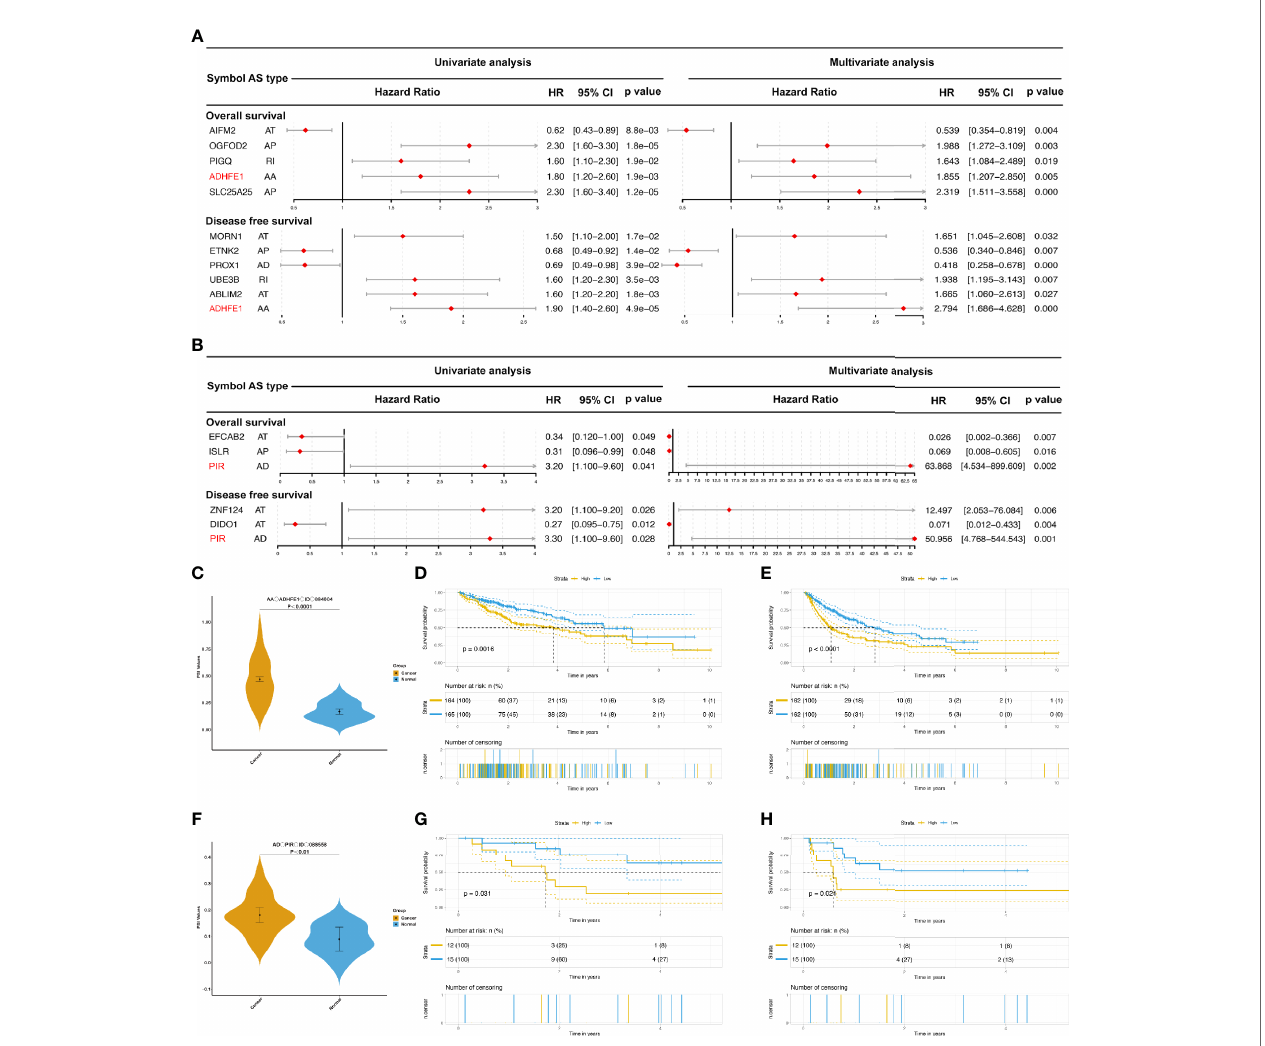
FIGURE 5 | The prognostic value of DEAS events in HCC and ICC. (A, B) The forest map results of cox analysis of OS- and DFS-DEAS events in HCC (A) and ICC (B) were showed, and the common DEAS event in both OS and DFS was marked as red. (C) The difference PSI values of AA_ADHFE1_ID_084004 between normal tissues and HCC tissues. (D, E) Prognostic signatures based on AA_ADHFE1_ID_084004 in HCC for both OS (D) and DFS (E) . (F) The difference PSI values of AD_PIR_ID_008558 between normal tissues and HCC tissues. (G, H) Prognostic signatures based on AD_PIR_ID_008558 in HCC for both OS (G) and DFS (H)